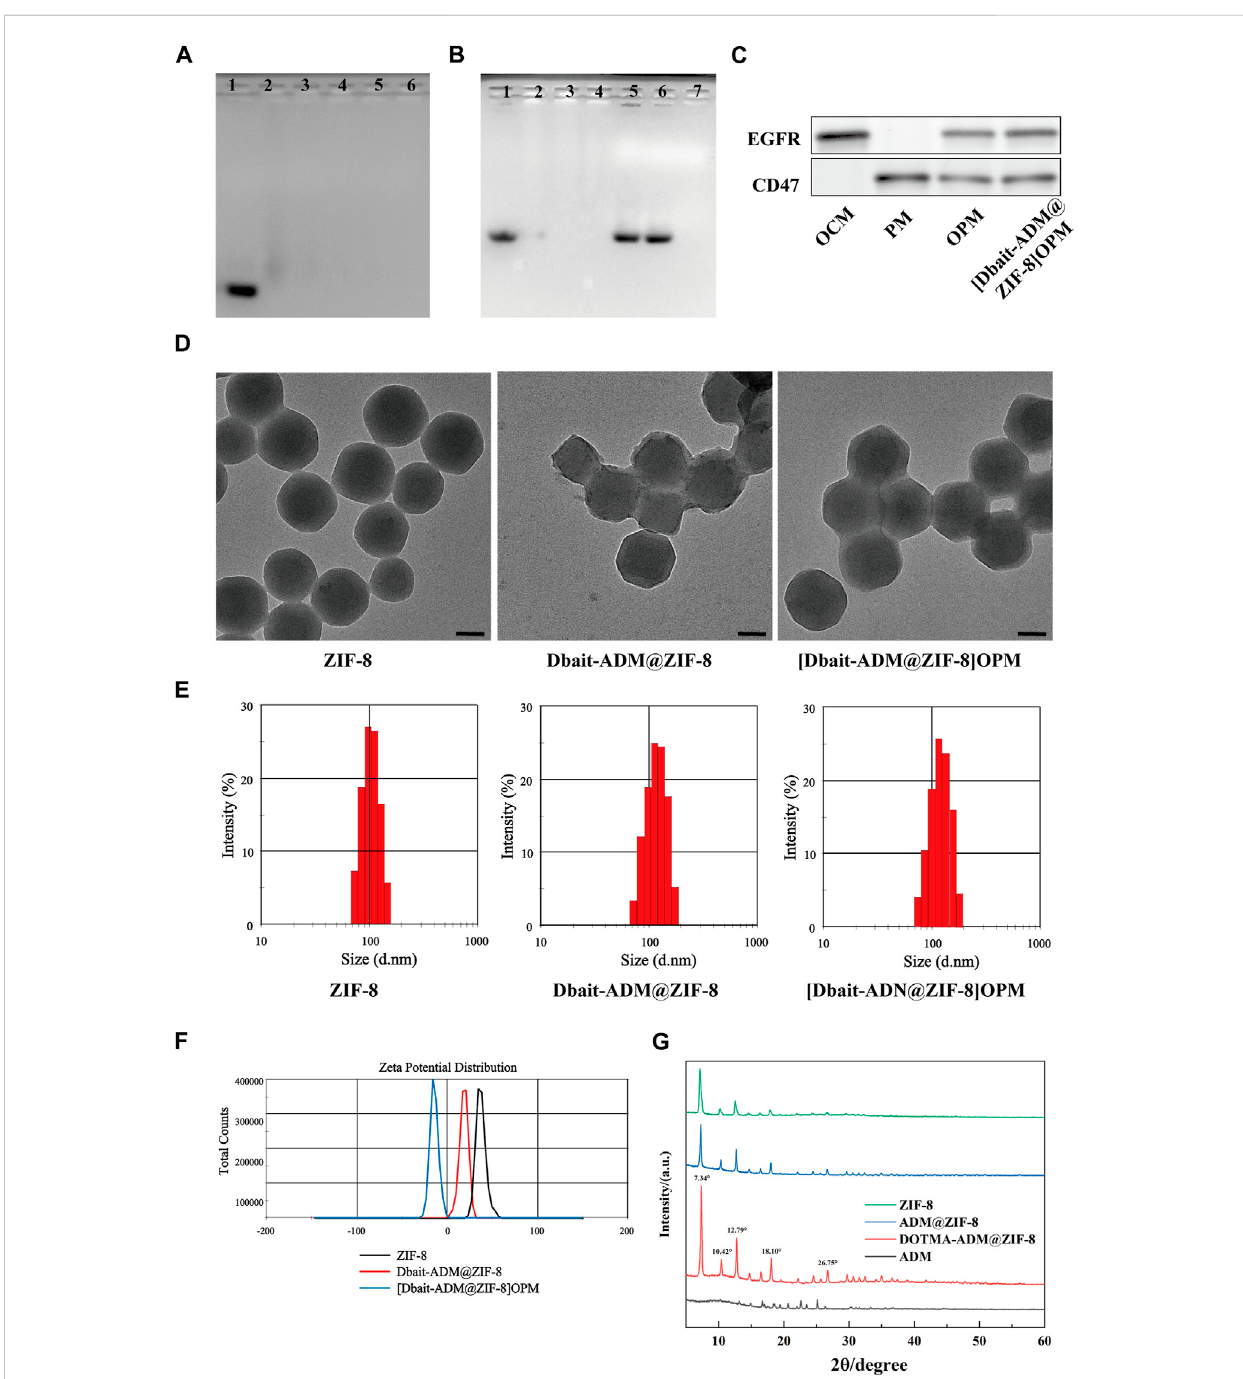
FIGURE 2 Characterizationof[Dbait-ADM@ZIF-8]OPM. (A) AgarosegelelectrophoresiswasusedtodeterminethestabilityofthenanocarriersatdifferentN/P ratios(1 – 6:Dbait = 1:4, 1:8,1:12,1:16,1:20) and (B) DNaseIdigestionandanion replacement (1:Dbait; 2 – 4:DnaseI treated=1:8, 1:10, 1:12; 5 – 7:Heparin treated=1:8,1:10,1:12)nanocarrierstability. (C) WesternblotanalysisofEGFRandCD47markersoriginatingfromOCM,PM,andOPM,[Dbait-ADM@ZIF- 8]OPM. (D) TEM images of ZIF-8, Dbait-ADM@ZIF-8, and [Dbait-ADM@ZIF-8]OPM. Scale bar, 50 nm. (E) Particle size of ZIF-8, Dbait-ADM@ZIF-8, [Dbait-ADM@ZIF-8]OPM. (F) Zeta potential of ZIF-8, Dbait-ADM@ZIF-8, [Dbait-ADM@ZIF-8]OPM. (G) XRD of ZIF-8, ADM@ZIF-8,